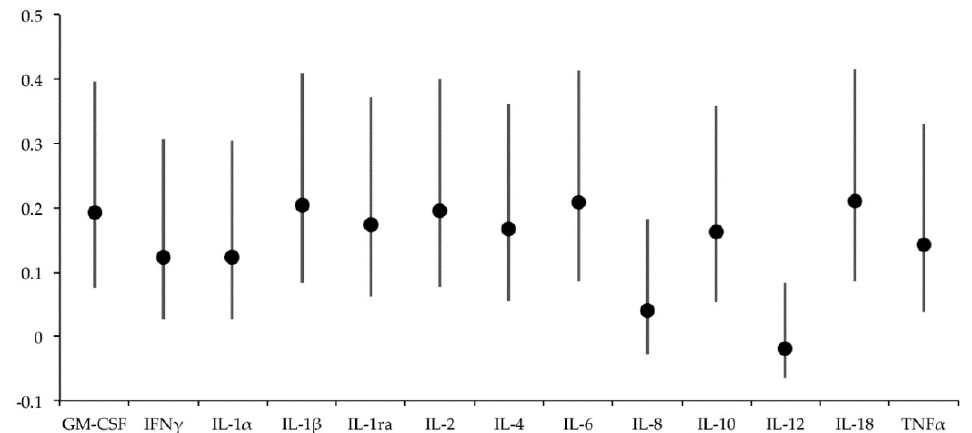
Figure 2. Intraclass correlation coefficient (ICC 3,1) values in terms of single measures (dot) and 95% confidence intervals (bars) of cytokine concentrations in 180 boar seminal plasma samples. Cytokines: granulocyte-macrophage colony-stimulating factor (GM-CSF), interferon-gamma (IFNγ), interleukin (IL)-1 α , IL-1 β , IL-1ra, IL-2, IL-4, IL-6, IL-8, IL-10, IL-12, IL-18, and tumor necrosis factor- α (TNF α ).